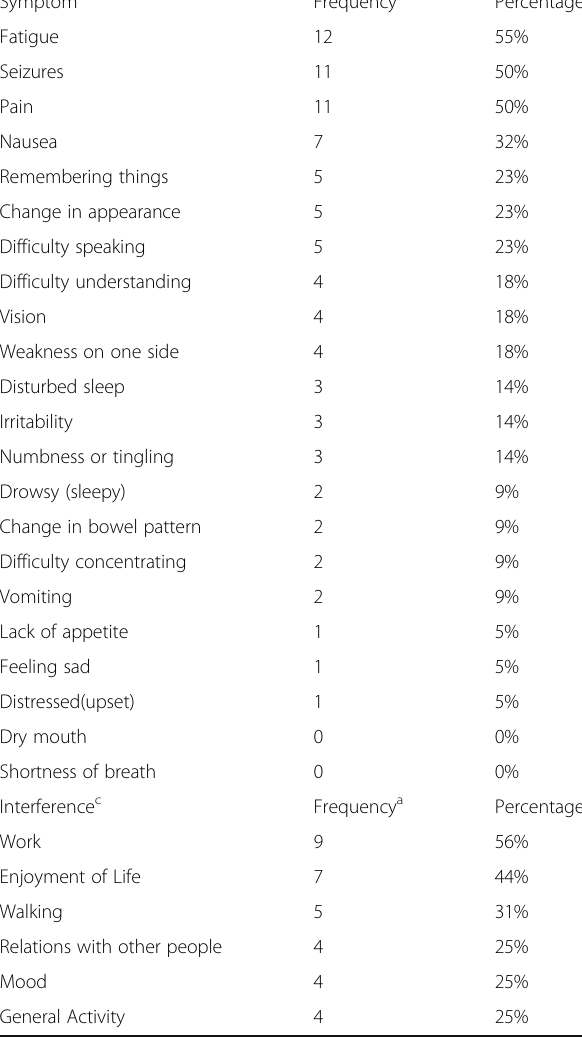
Table 2 Frequency Table of Symptom Codes Compared to MDASI-BT